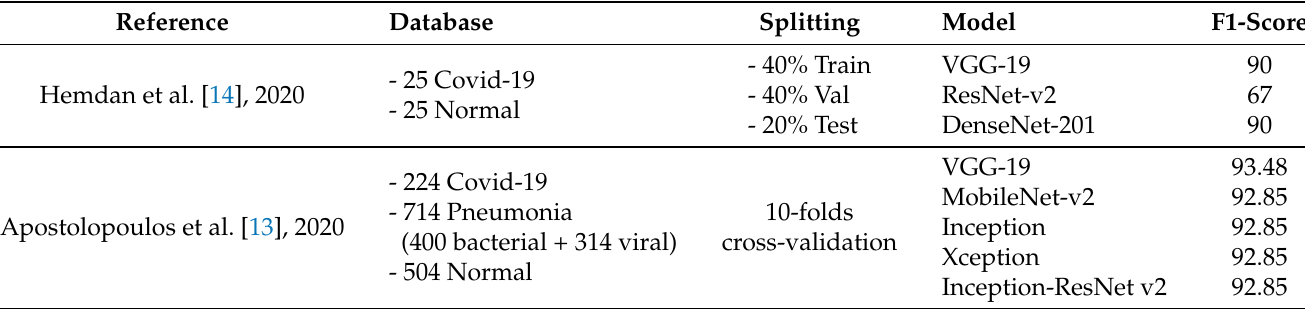
Table 1. State-of-the-art works